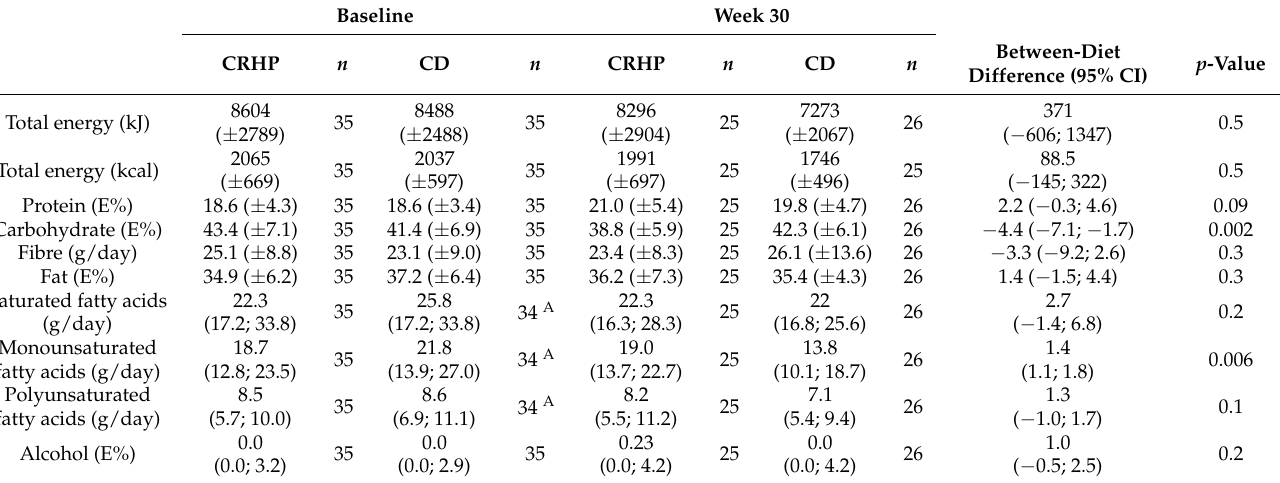
Figure 1. Participant flow diagram. Table 2. Daily dietary intake of energy and macronutrients assessed by 3-day food